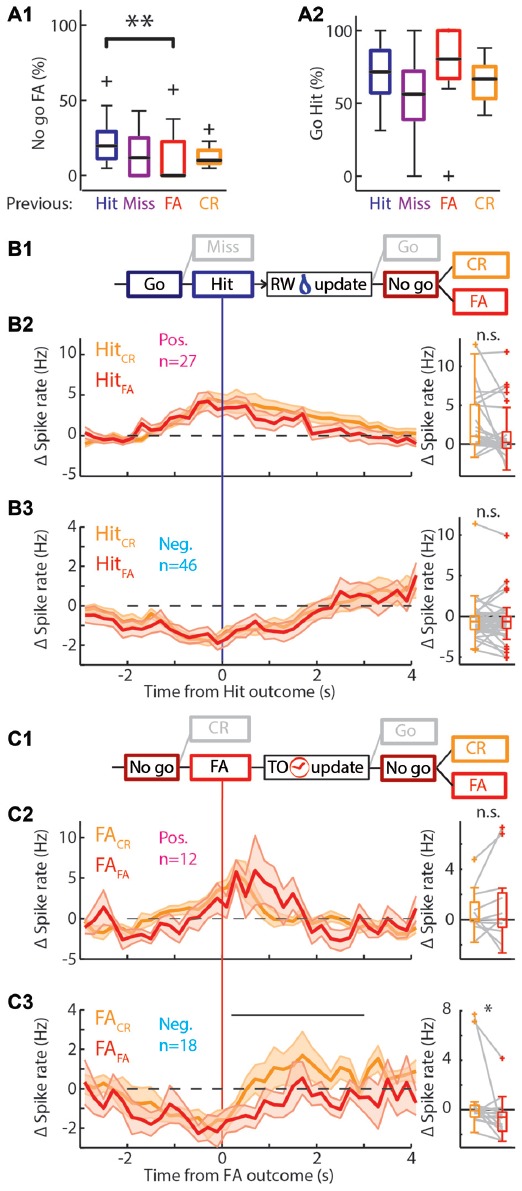
Behavioral change upon feedback. (A) Boxplots of the performance of the rat separated by outcome of the previous trial. (A1) There are significantly more/fewer FA errors in “No-go” trials if the previous trial was a Hit/FA respectively. (A2) There was no significant difference in the performance in “Go” trials based on the previous trial outcome. (B1) Schematic representation of the selection of trials for (B2,B3). Only those Hit trials that are followed by a “No-go” trial are used. RW is water reward. (B2) Left: average PETHs of the positively modulated population around Hit outcomes for trials that were followed by a “No-go” trial. Hit trials that were followed by CR (HitCR; orange) and those that were followed by a FA (HitFA; red) show similar time courses of Δ spike rate (n = 27). Right: there was no significant difference of the median Δ spike rate in HitCR and HitFA trials. (B3) As (B2) for the negatively modulated population (n = 46). (C1) Similar to (B1) for FA trials. TO is time out punishment. (C2) Left: PETHs of the Δ spike rate of the positively modulated population during FA trials that are followed by a CR trial (FACR; orange) and those that are followed by another FA trial (FAFA; red; n = 12). Right: there was no significant difference of the median Δ spike rate in FACR and FAFA trials. (C3) As (C2) for the negatively modulated population (n = 18). The black bar indicates the window for right panel. Right: the median Δ spike rate during 0.2–3 s after the FA trial outcomes was significantly higher during FACR trials than FAFA trials. n.s. not significant (p > 0.05), *p < 0.05, **p < 0.01.